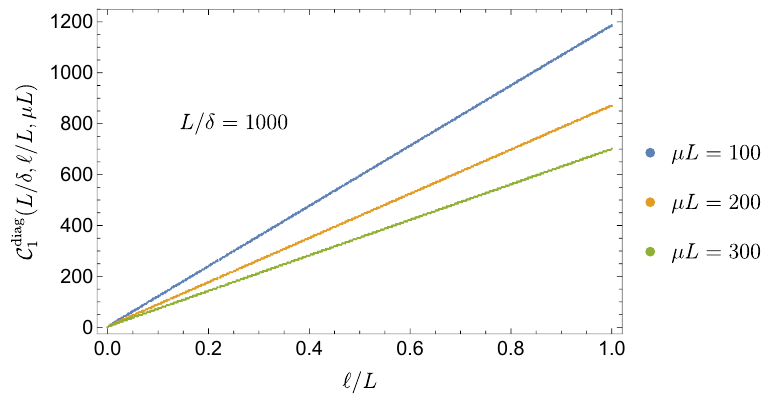
Figure 15 . Puri(cid:12)cation complexity in the diagonal basis for subregions of the vacuum as a function of the subregion size. The cuto(cid:11) was set to N = L=(cid:14) = 1000 and the mass to mL = 0 : 01. The puri(cid:12)cation complexity for the subregion with ‘ ! L agrees with the complexity of the ground state in diagonal